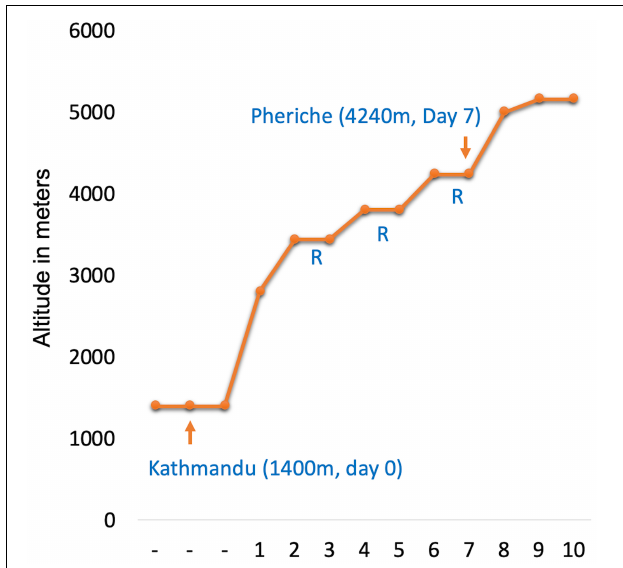
FIGURE 1 | Ascent profile with sample collection altitudes indicated with arrows and labels. Study participants flew from baseline (day 0) Kathmandu to 2,800 m to begin the trek. Three non-trekking rest days are indicated by “R.” Epigenome wide association study was performed on matched samples collected at 1,400 m (day 0) and 4,240 m (day 7).